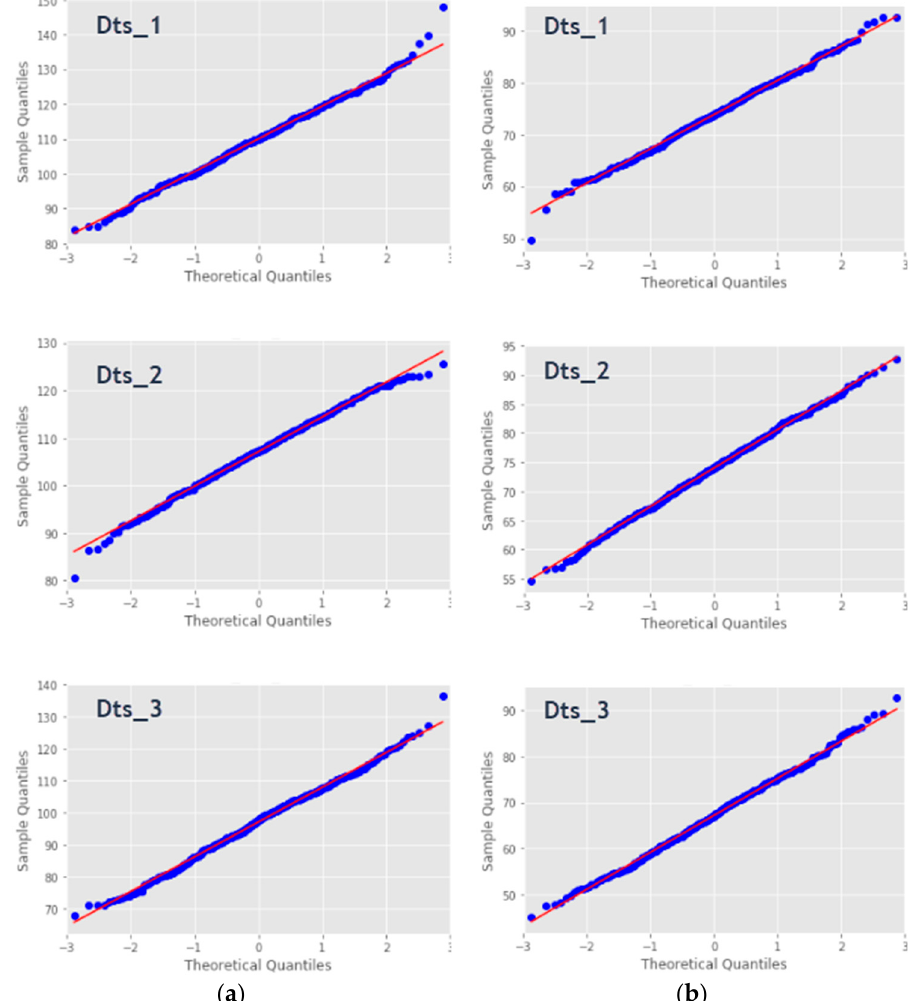
Figure12. ( a )Quantile–Quantile(Q–Q)-plotofSystolicmeasuresand( b Figure 12. ( a ) Quantile–Quantile (Q–Q)-plot of Systolic measures and ( b ) Q–Q-plot of Diastolic measures.